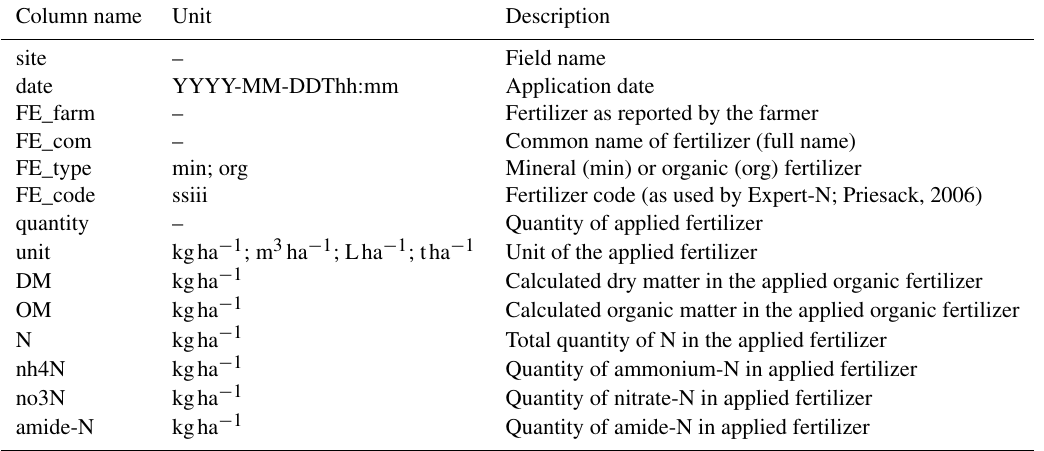
Table 9. Determined variables and description of the fertilizer data files